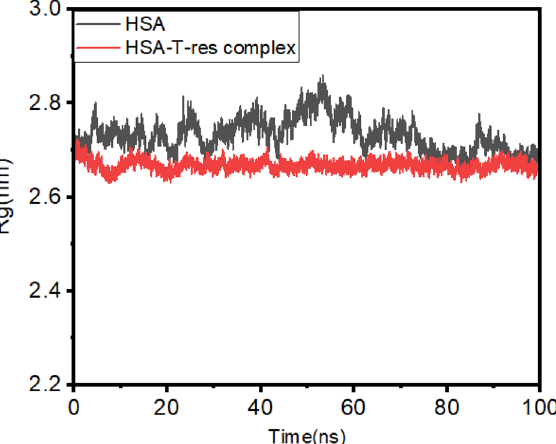
Figure 14. Radius of gyration plot from 0 to 100 ns time for HSA and HSA-T-res complex obtained from MD simulation studies.